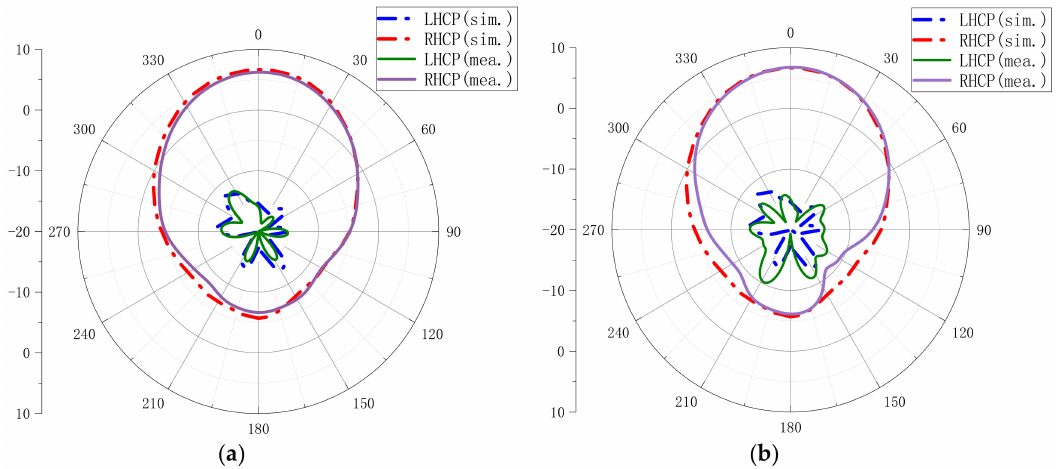
Figure 10. Comparison of simulated and measured radiation patterns at 5.5 GHz: ( a ) xoz-plane; ( b ) yoz-plane. Table 2. Performance comparison of recently reported CP antennas based on